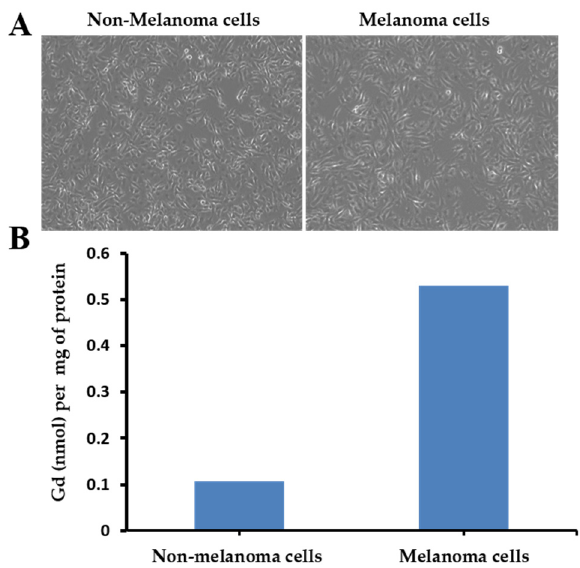
Figure 5. In vitro cell labeling. ( A ) Phase-contrast micrographs of non-melanoma and melanoma cells one hour after the addition of 0.5 mM Gd-DO3A-Am-PBA (10 × magnification). ( B ) Quantification of binding affinity by ICP-MS. Results are expressed as per mg of protein.